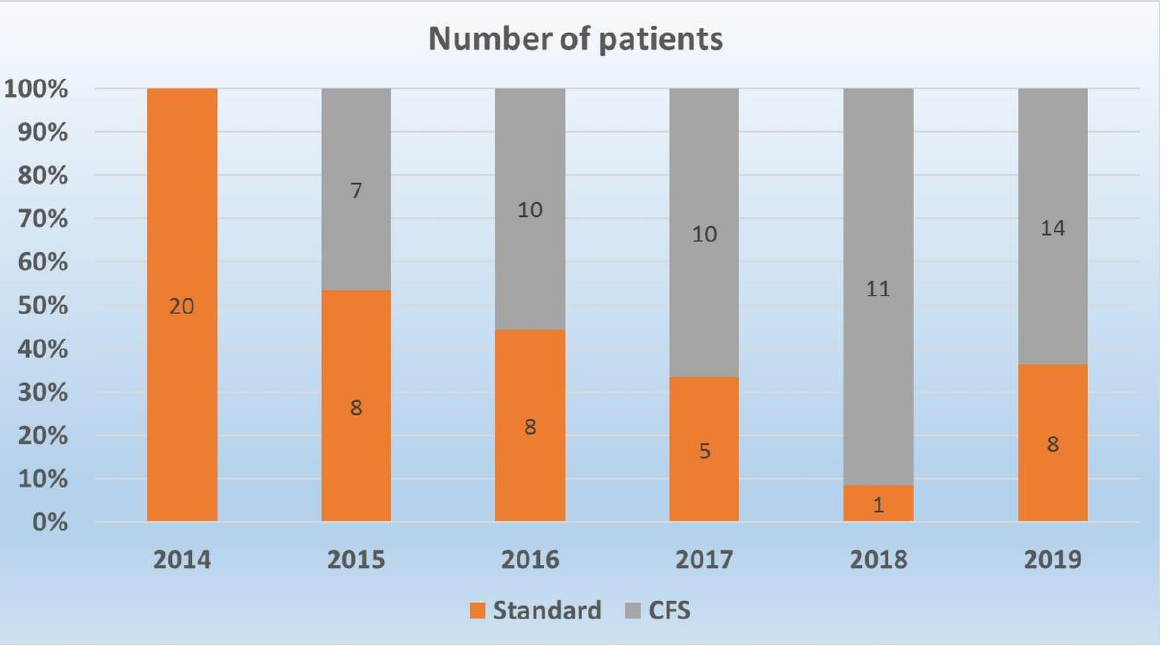
Figure 2. Distribution of ablation catheters type over time. Abbreviations: CFS—contact force-sensing.